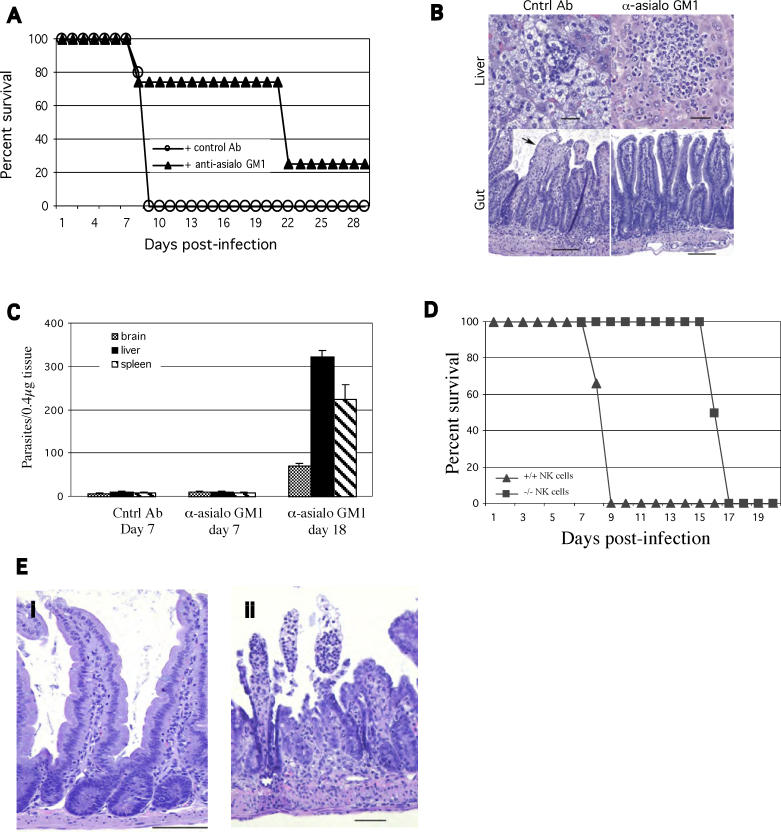
Effect of NK Cells on Survival following T. gondii Infection of C57BL/6 Mice(A–B) NK cell depletion of wild type. C57BL/6 mice were infected orally with 50 cysts. One day before and every day after infection mice were injected intraperitoneally with anti-asialo GM1 antibody. The treatment was continued for the duration of the experiment. Eight animals were treated per group, and data are representative of two separate experiments. Survival (A) and histopathology (B) of NK cell depleted and nondepleted T. gondii-infected CCR5+/+ C57BL6 mice. Photomicrographs of hematoxylin and eosin-stained liver and ileum of small intestine isolated from infected anti-asialo GM1 and control antibody-treated mice. NK cell-depleted mice had essentially normal small bowel morphology, and the livers showed an acute inflammatory response compatible with acute T. gondii infection. In nondepleted wild-type mice, the small bowel showed extensive, scattered, superficial necrosis, with acute inflammation, including polymorphonuclear cells in the lamina propria. The livers show marked, confluent fatty degeneration of hepatocytes, with small inflammatory nodules in the parenchyma consistent with a hyperimmune inflammatory response. Size bars: liver, 20 μm; small bowel 100 μm. The arrow indicates an area of superficial necrosis of epithelial cells.(C) Parasite load. Wild-type C57BL/6 mice were infected with 50 cysts orally and NK cell depletion performed as described above. At day 7 and 18 PI mice (three per group) were sacrificed and tissues (brain, liver, and spleen) analyzed for parasite load by competitive DNA PCR.(D–E) NK cell adoptive transfer. NK cells from CCR5−/− and wild-type C57BL/6 mice were isolated and 107 purified NK cells were injected to naïve CCR5−/− mice. Recipients were subsequently challenged with 50 cysts of T. gondii. Six animals were treated per group, and data represent two separate experiments. Survival (D) and histopathology (E) of T. gondii-infected CCR5−/− C57BL/6 treated with either CCR5−/− or CCR5+/+ NK cells. Mice described above (two mice each) were sacrificed on day 9 and ileum isolated and stained with hematoxylin and eosin. In (E), small bowel of CCR5−/− C57BL/6 recipients treated with CCR5−/− NK cells (i) demonstrates preservation of the mucosa, as seen in large areas of the bowel wall. Bar, 100 μm. In contrast, in CCR5−/− C57BL/6 recipients treated with wild-type NK cells (ii), the small bowel mucosa is characterized with superficial necrosis and with an inflammatory cell infiltrate of in the lamina propria, typical of hyperinflammatory response. Bar, 100 μm.